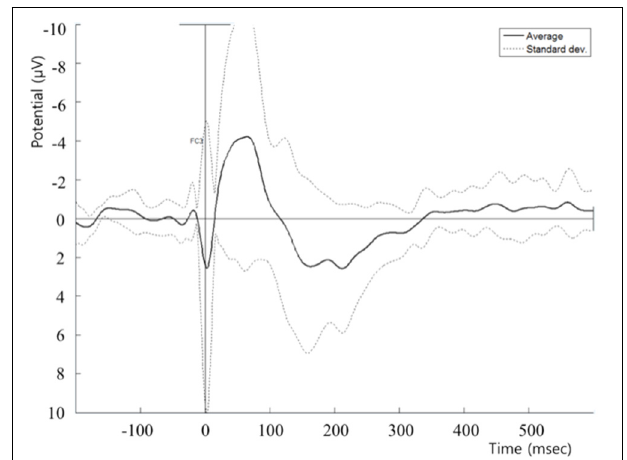
FIGURE 1 | Post cTBS T0 TEP recorded at the FC5 electrode. cTBS, continuous theta-burst stimulation; TEP, transcranial magnetic stimulation (TMS)-evoked